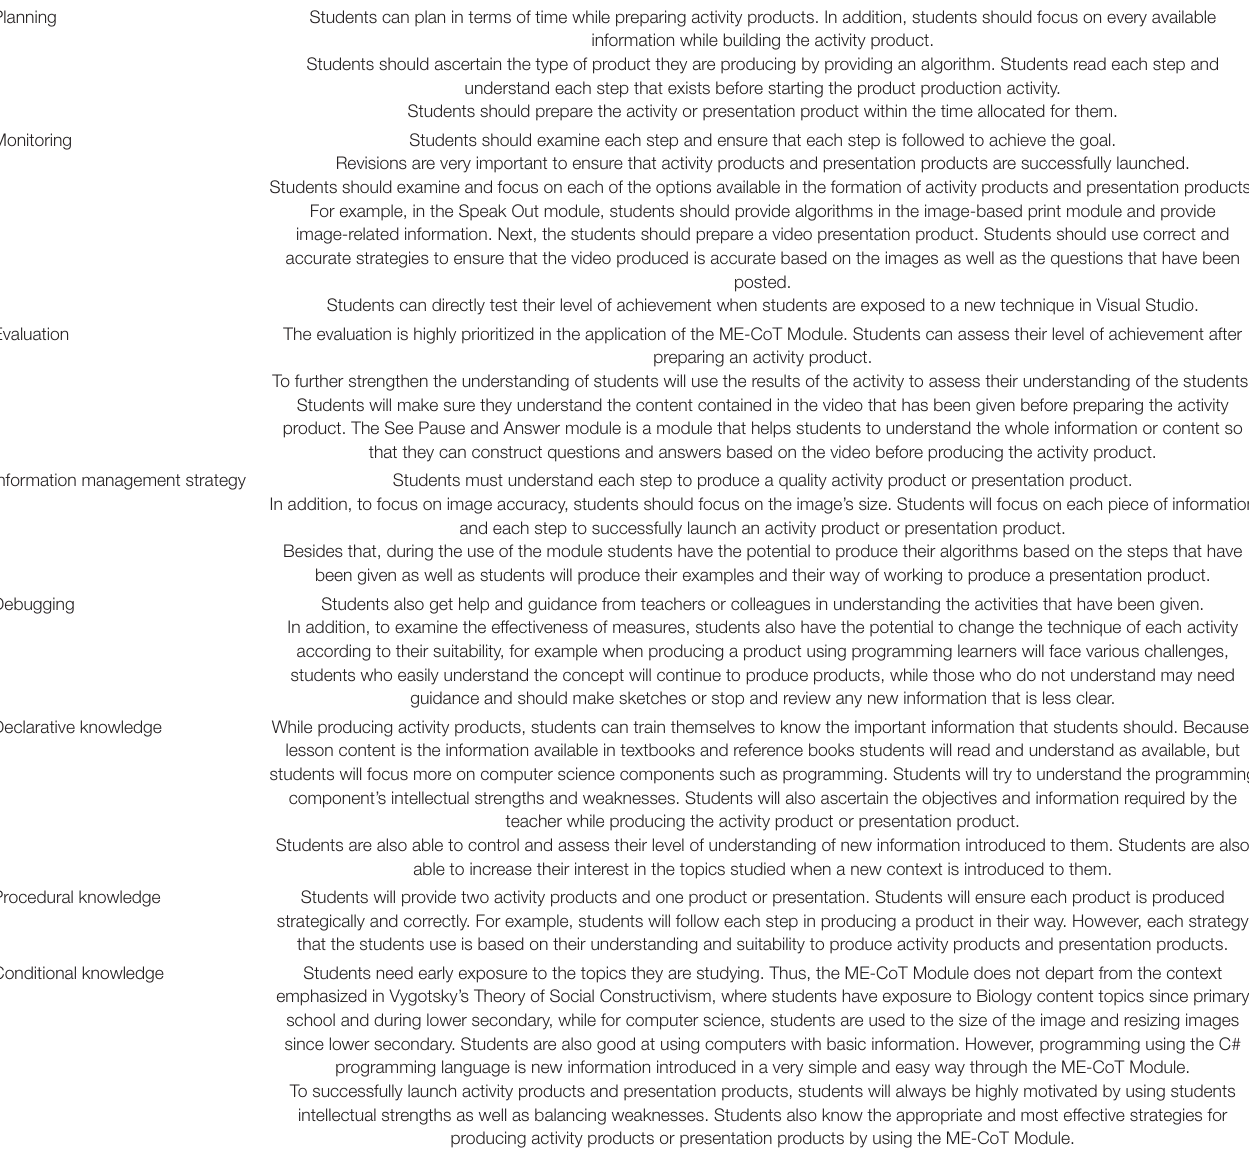
TABLE 2 | Fostering metacognitive awareness by implementing the ME-CoT Module. Metacognitive awareness Fostering metacognitive awareness in the application of the ME-CoT Module